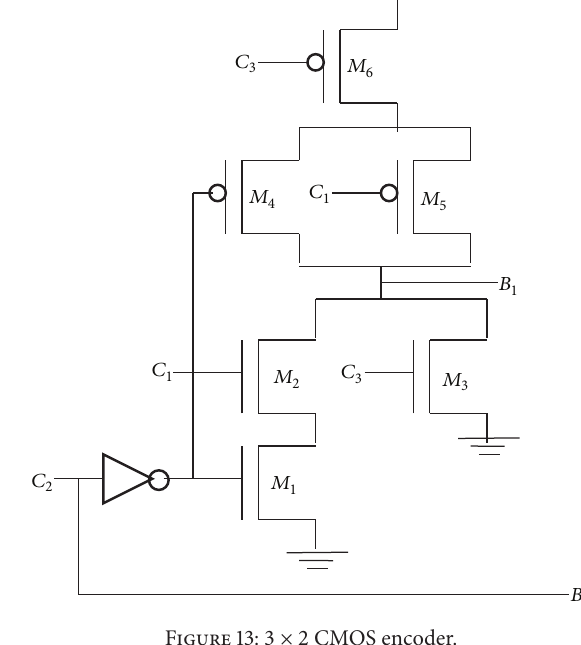
Figure 13: 3 × 2 CMOS encoder.